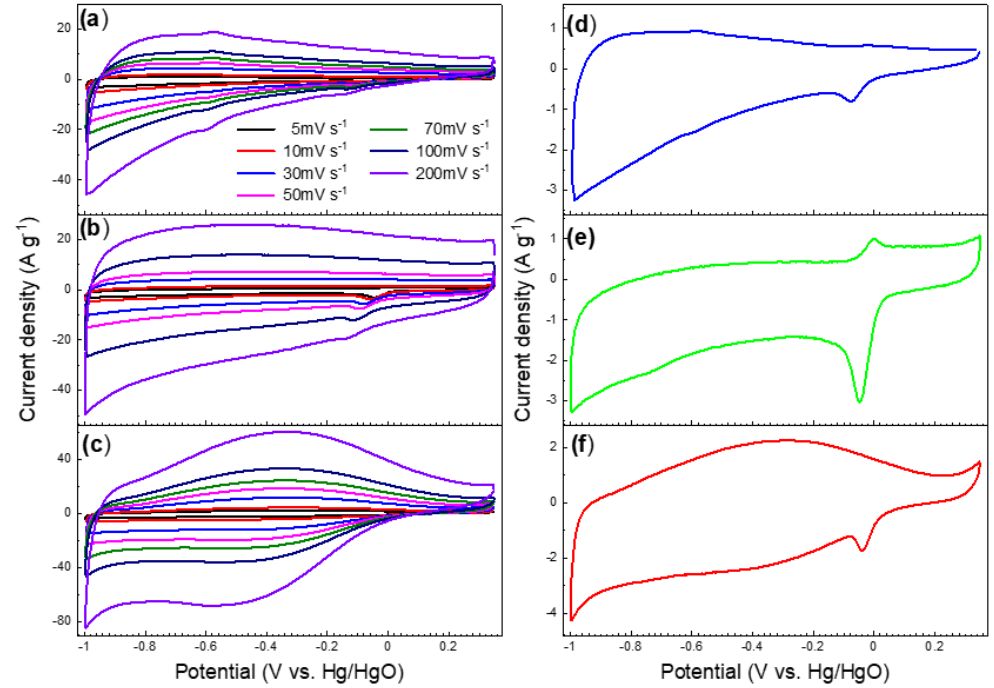
Figure 8. Cyclic voltammetry (CV) curves of carbon/DDSQ hybrids derived from ( a , d ) pure phenolic, ( b , e ) PDDSQ ‐ 50, and ( c , f ) pure PDDSQ, measured at ( a – c ) various scan rates and ( d – f ) a scan rate of 5 mV s –1 in 1 M KOH.